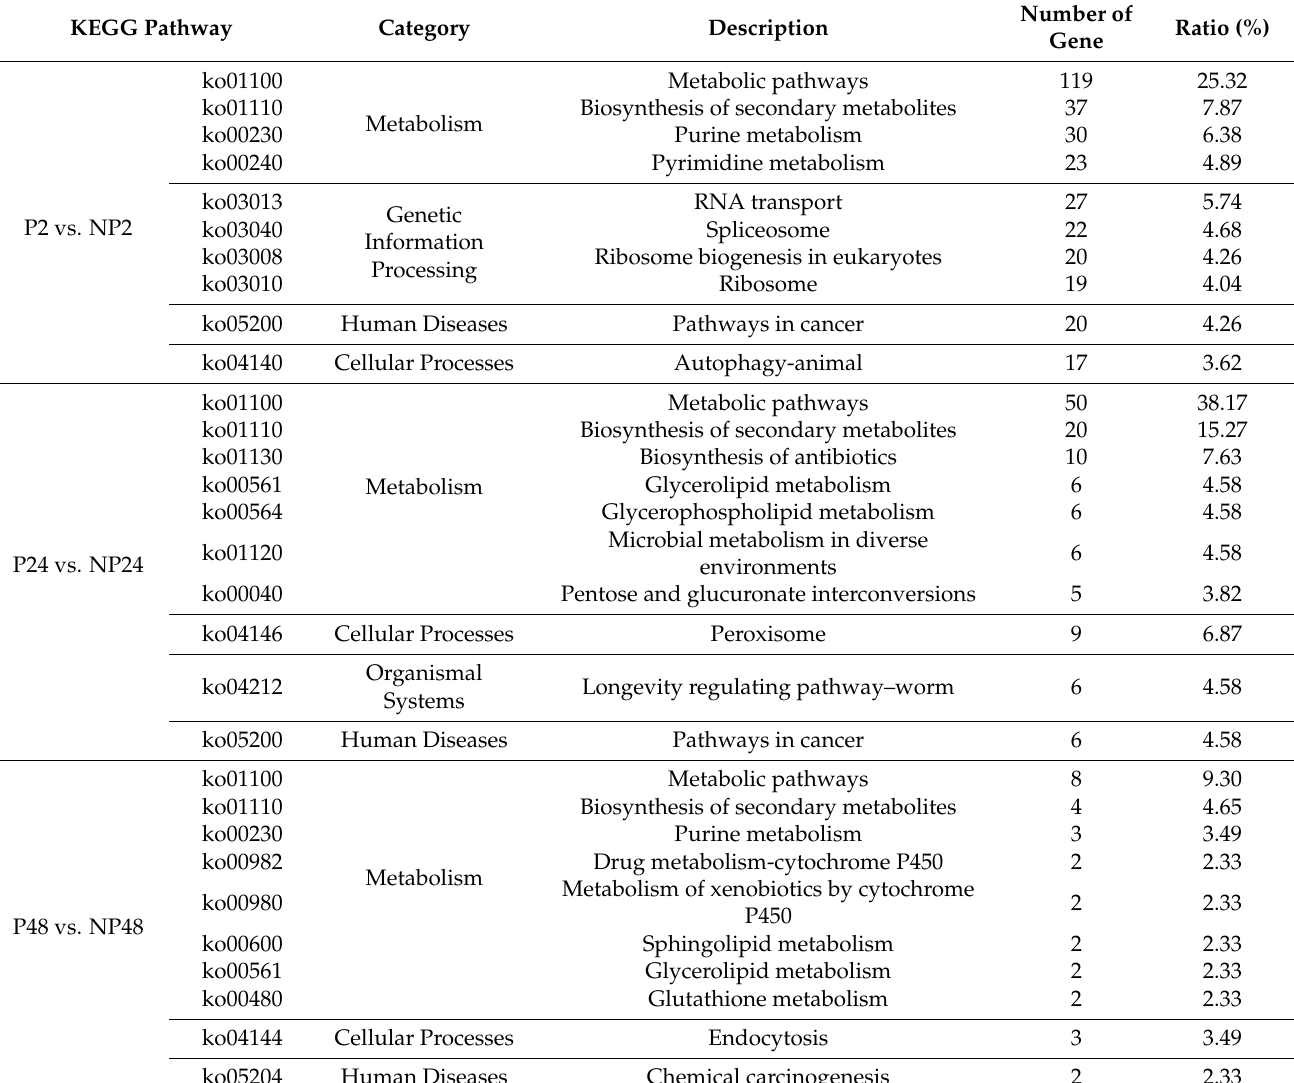
Table 1. Top 10 enriched KEGG pathways in DEGs identified from the P2 vs. NP2, P24 vs. NP24, and P48 vs. NP48